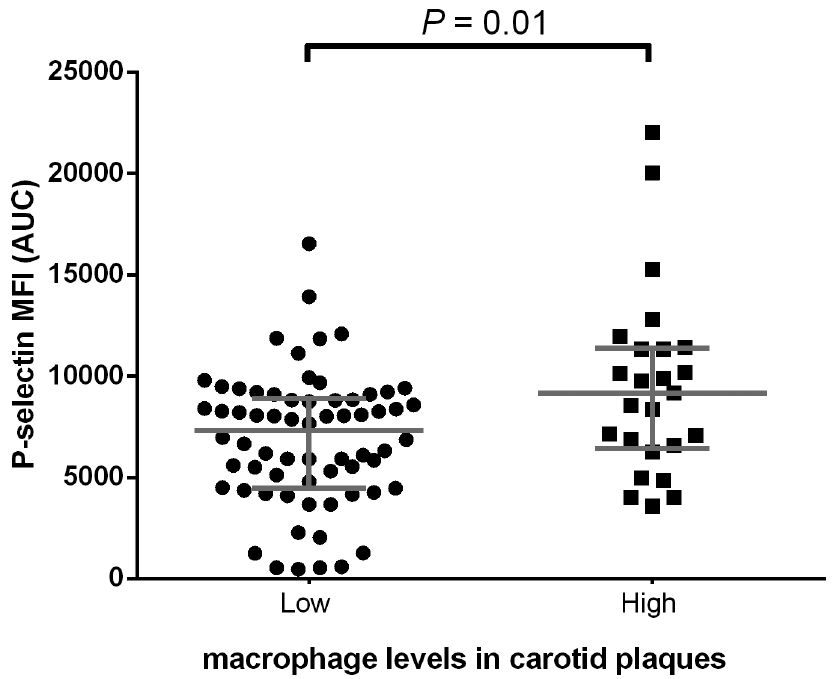
Figure 3. Platelet reactivity related to macrophage levels. Comparison of the AUC after ADP stimulation between low (n=67) versus high macrophage levels in atherosclerotic carotid plaques (n=24). Grey bars represent means with standard deviations. MFI=mean fluorescence intensity, AUC=area under curve, ADP=adenosine diphosphate.